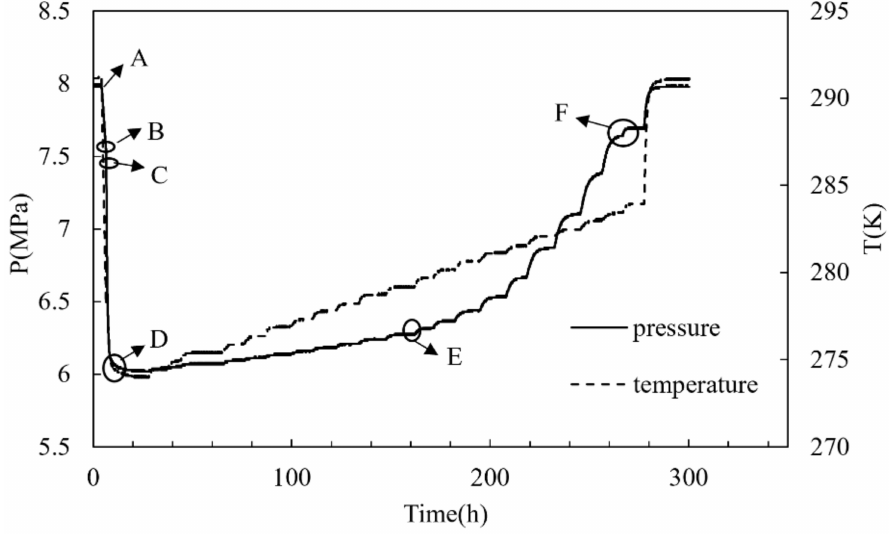
Figure 5. Pressure and temperature variation diagram of methane hydrate in fine-grained